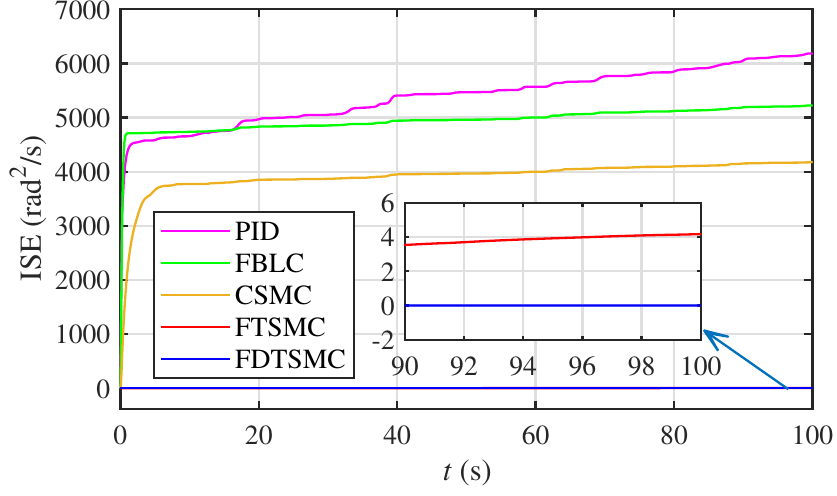
Figure 15. Integral squared error.